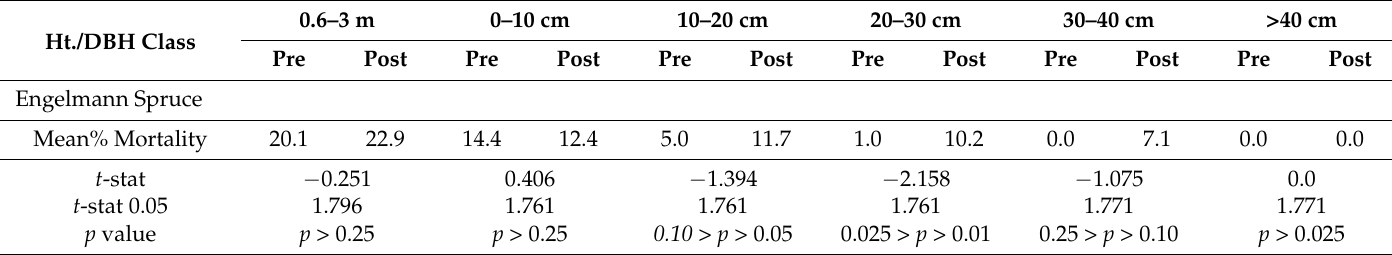
Table 4. Results for two-sample one-tailed T test run on individual species in the Spruce-fir